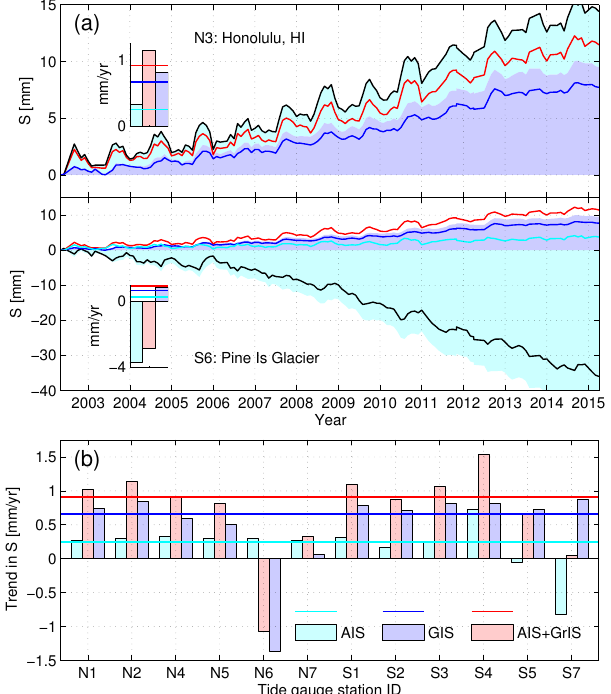
Figure 5. Magnitudes and trends of sea-level change at 14 selected locations. (See Table 3 for their description and Fig. 4a to locate their position on the global map.) (a) Change in relative sea level over time at two representative sites. Average rates of relative sea- level change are also shown in the insets. (b) Rate of change in relative sea level, averaged over the GRACE period, at 12 other locations. Cyan and blue colors (both fill and line) represent the contribution from the AIS and GrIS, respectively. The combined contributions of ice sheets are shown in red. Black lines in Fig. 5a represent the local values and all others denote the global mean val-